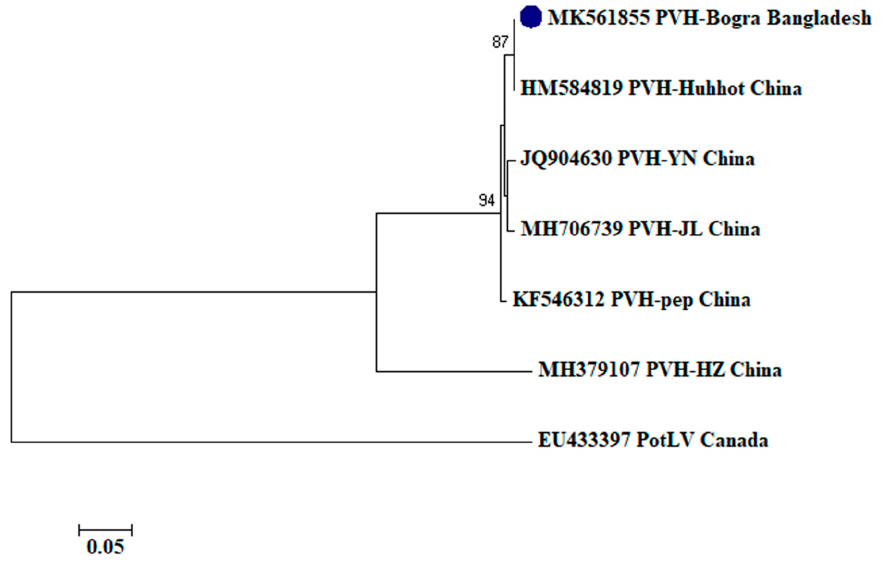
Figure 5. Phylogenetic analysis of Potato virus H detected from Bangladesh based on the coat protein gene sequences (nt) of different selected isolates from the NCBI database. The phylogenetic tree was generated by MEGA7 using neighbor-joining method with 1000 bootstrap replicates, and only values >50% are shown at the nodes. An isolate of Potato Latent virus (PotLV) from Canada was used as an outgroup.